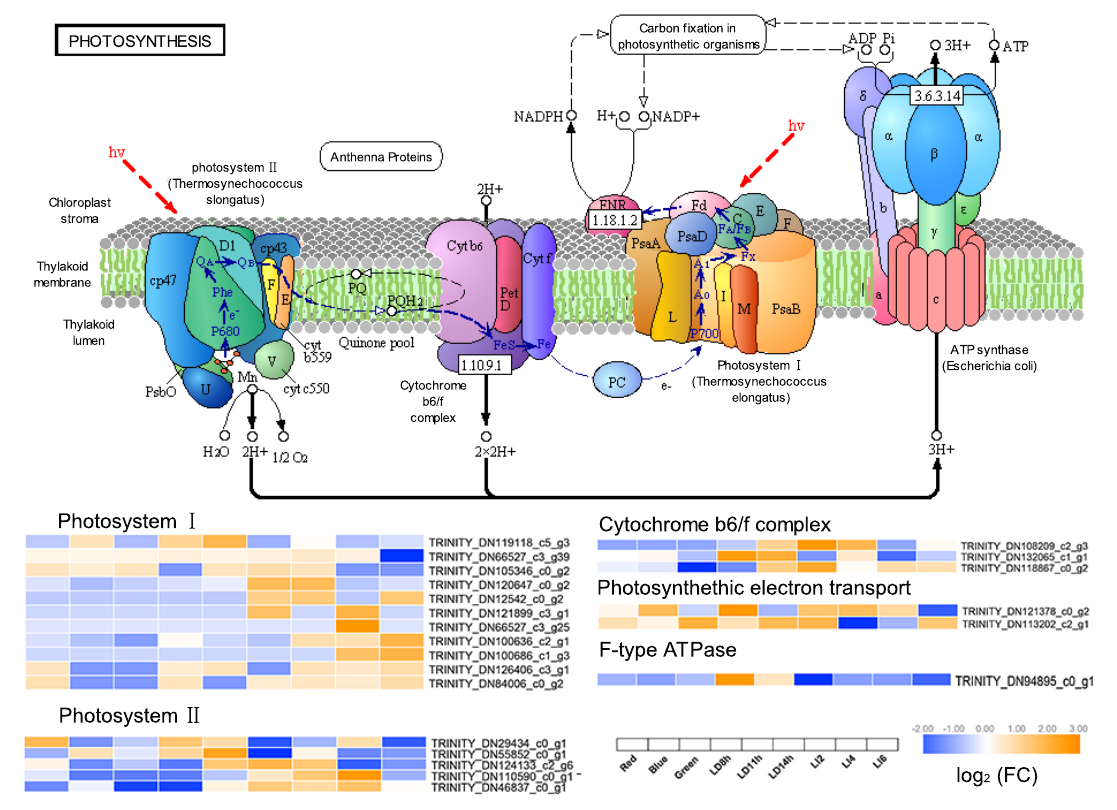
Figure 6. Di ff erentially expressed genes in the photosynthesis